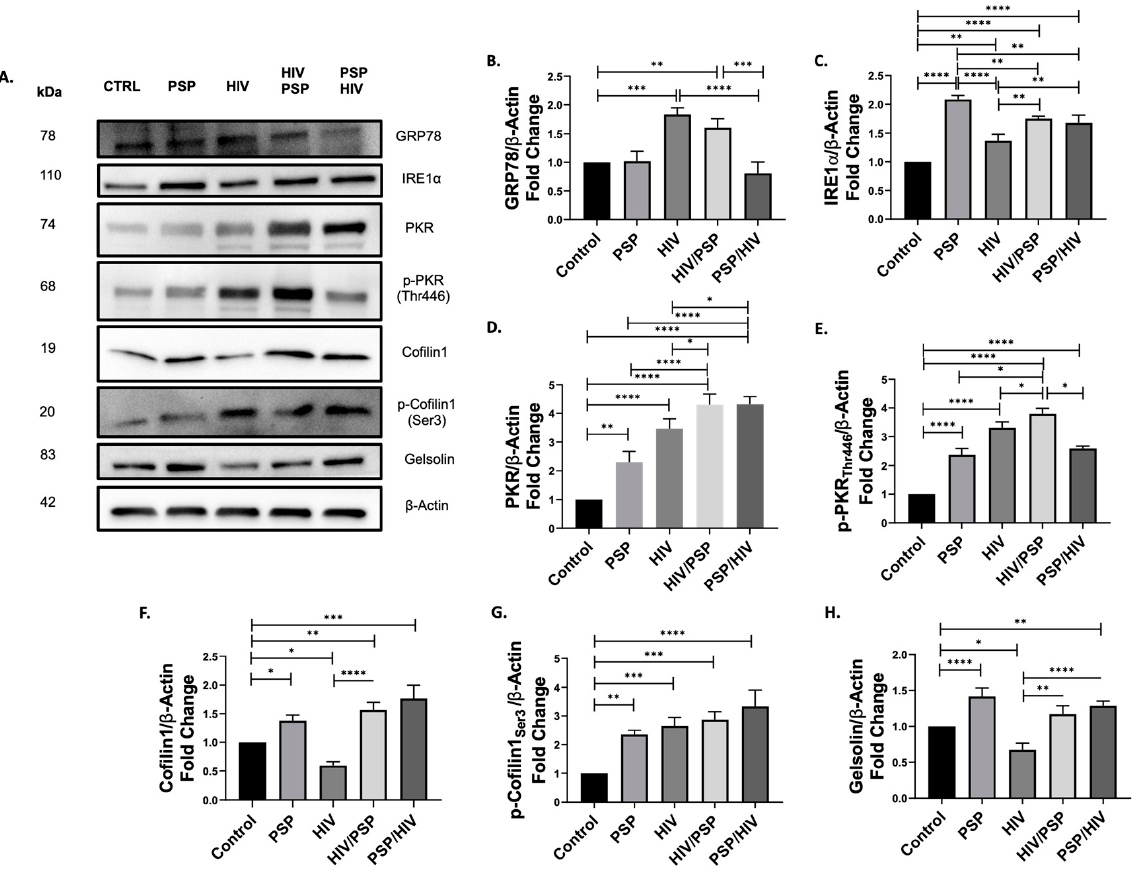
Figure 4. Western blot results related to UPR, IFN, and cytoskeletal biomarkers in PSP-treated THP1 monocytic cells. ( A ) Representative Western blot data for the protein expression levels of UPR: ( B) GRP78; ( C ) IRE1 α ; IFN: ( D ) PKR; ( E ) p-PKR; ADF: ( F ) Co fi lin1; ( G ) p-Co fi lin1; and ABP: ( H ) Gelsolin signaling. β -Actin was used as a loading control and for normalization of data. Images were quanti fi ed using the ImageJ software (NIH, version 1.52a) by comparing the integrated density value with the control group. Mean ± SEM and signi fi cant di ff erence (*), p ≤ 0.05, (**), p ≤ 0.01, (***),